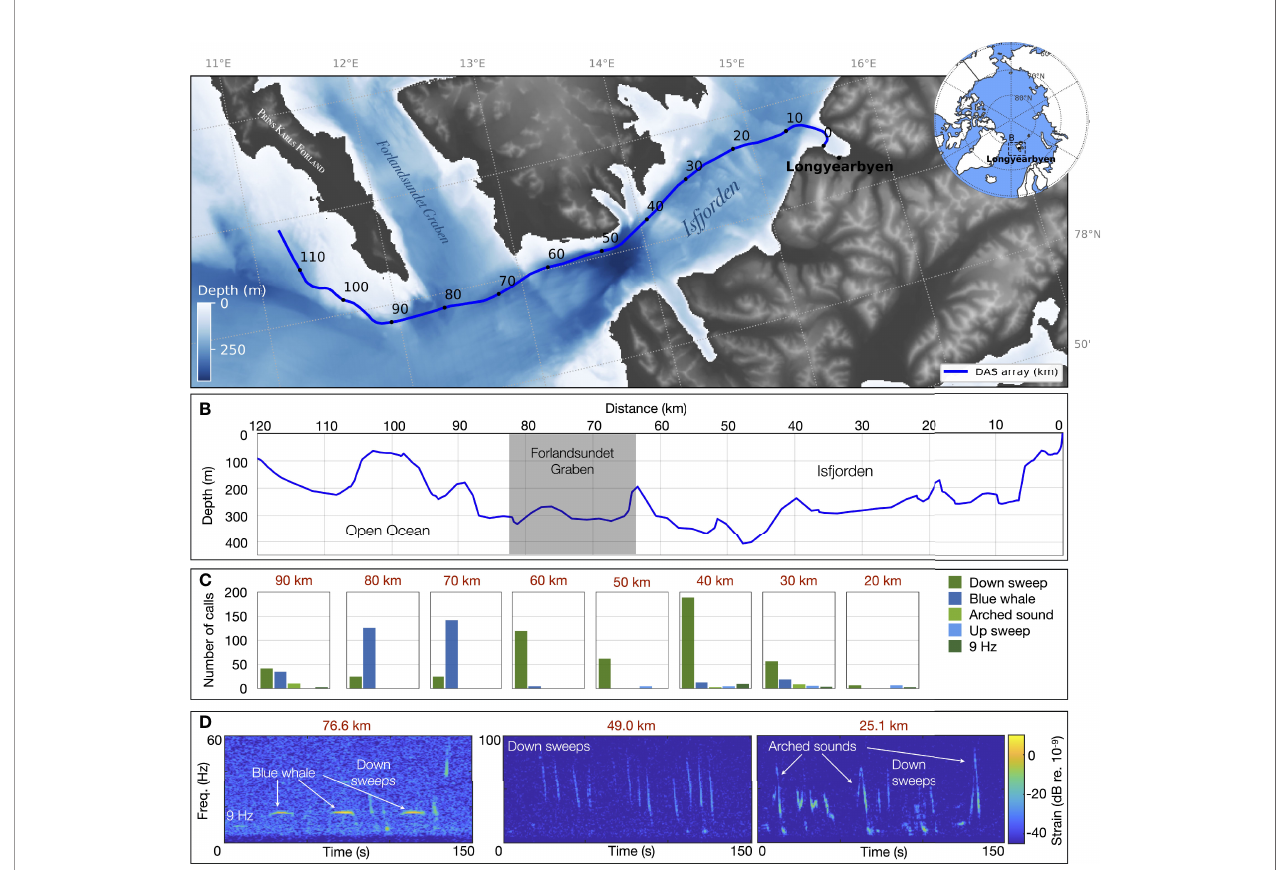
FIGURE 2 | Baleen whale vocalizations detected over the 120 km of the Svalbard underwater distributed acoustic sensing (DAS) array. (A) The DAS crosses Isfjorden out to the open sea, bypassing the South of Prins Karls Forland in Svalbard, Norway. The interrogator end of the fi ber is located on shore in Longyearbyen, recording data with a spatial sampling of 4.08 m at a sampling frequency of f s = 645.16 Hz between June 23 and August 5, 2020. (B) The DAS fi ber optic cable is trenched 1-2 m deep in the sea fl oor and follows bathymetric variations with an average depth of ≃ 216 m. Number of calls (C) and examples (D) representative of the diversity of baleen whale vocalizations detected along the DAS during the entire recording period. Associated sounds are available in supplementary material Audio 1 – 3